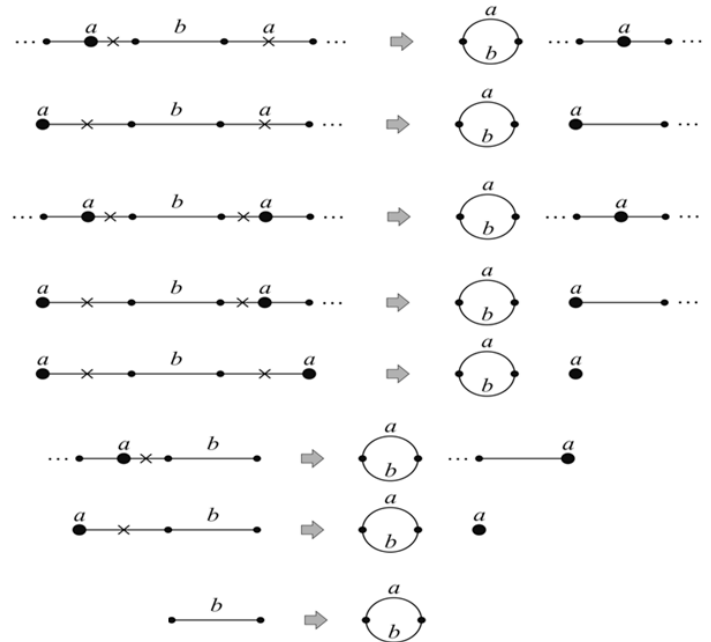
Figure 1. Cutting out a conventional b -edge. Singular vertices are marked by large circles. The cases differ by the form of edges adjacent to the edge to be cut out. From top to bottom: singular nonhanging and conventional; hanging and conventional; both singular nonhanging; hanging and singular nonhanging; both hanging; only one singular nonhanging; only one hanging; no adjacent edges.